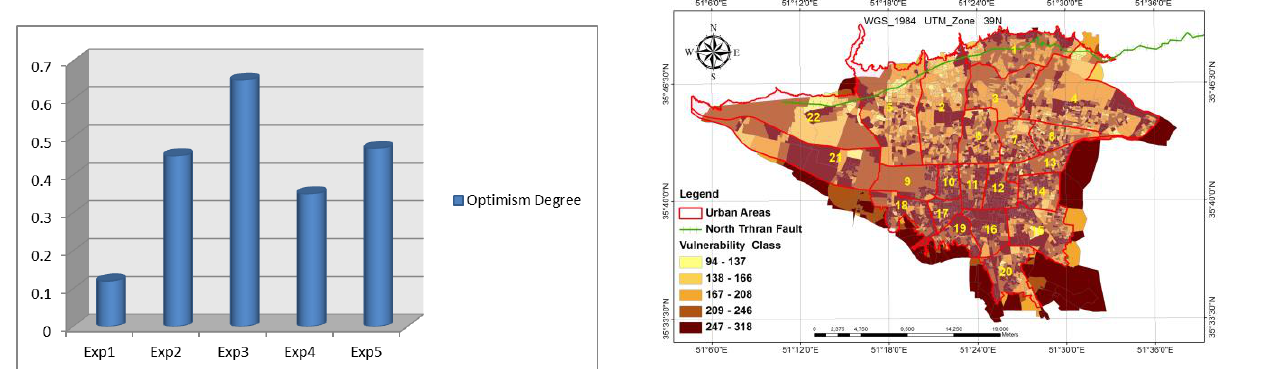
Figure 4. Optimism degree of experts